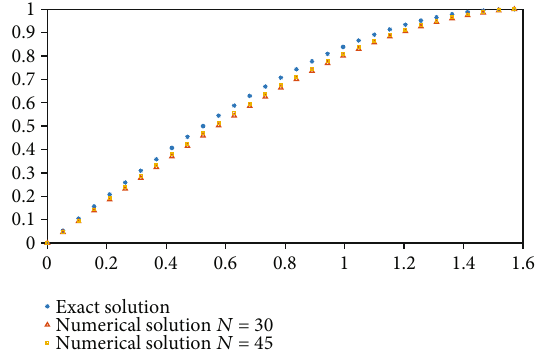
Figure 4: Solution of Test 2 when α = 0 : 8